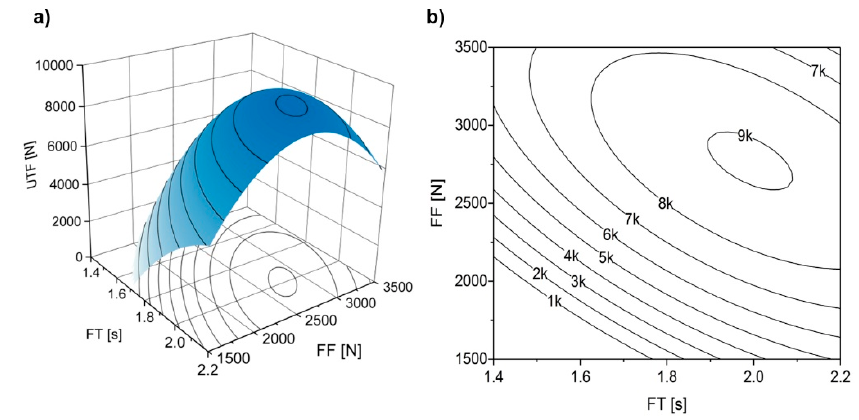
Figure 17. Effect of FT × FF two-way parameter interaction on UTF (in newton), ( a ) surface and ( b ) contour plots. RS set at 19,000 rpm, FoF at 4500 N, and FoT at 1.5 s.